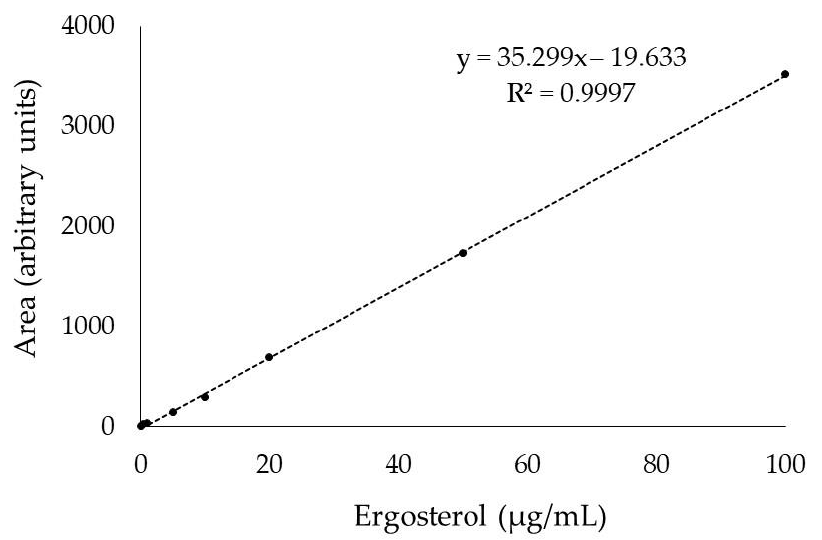
Figure 3. Standard calibration curve built in the range 0.1–100.0 µ g/mL of ergosterol using the optimised HPLC-FLD/DAD method.